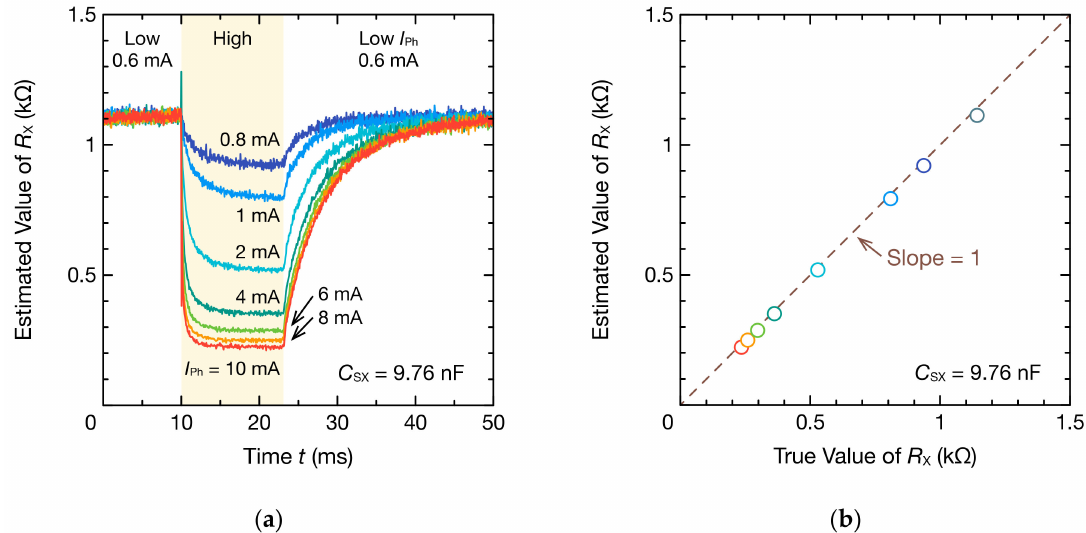
Figure 18. Resistance R X of the photocell estimated using oscillation waveforms in Figure 17a and DFT: ( a ) time–resistance curves and ( b ) saturation values at a high I Ph period. Time of the time–resistance curves corresponds to the representative points of time in Figure 17b.